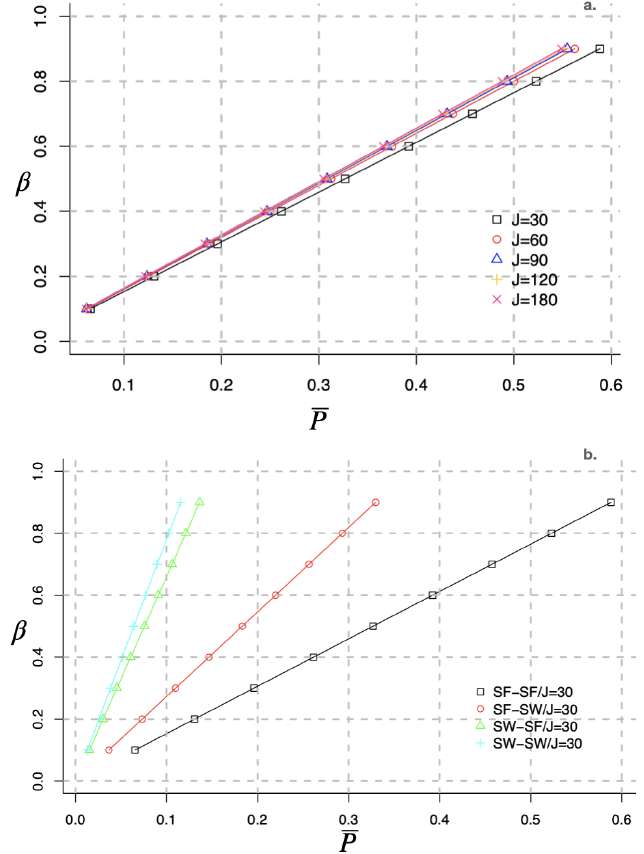
Figure 5. Participation coefficient vs. infection rate, under the number of quality parameters. We show in ( a ) the infection rate as function of the mean value of the participation coefficient in M , against the J parameters in M (cid:48) , taking into consideration a network topology hypothesis for the co- adoption that follows the scheme SF-SF. In ( b ), by fixing the J = 30, we vary the network hypothesis, by including also the small-world